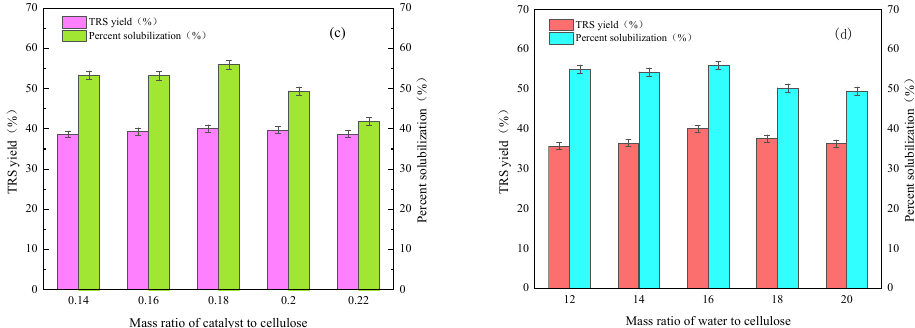
Figure 5. The effect of reaction time ( a ) temperature ( b ) mass ratio of catalysts to cellulose ( c ) and mass ratio of water to cellulose ( d ) on TRS yield and cellulose conversion over Vrm-HS35.